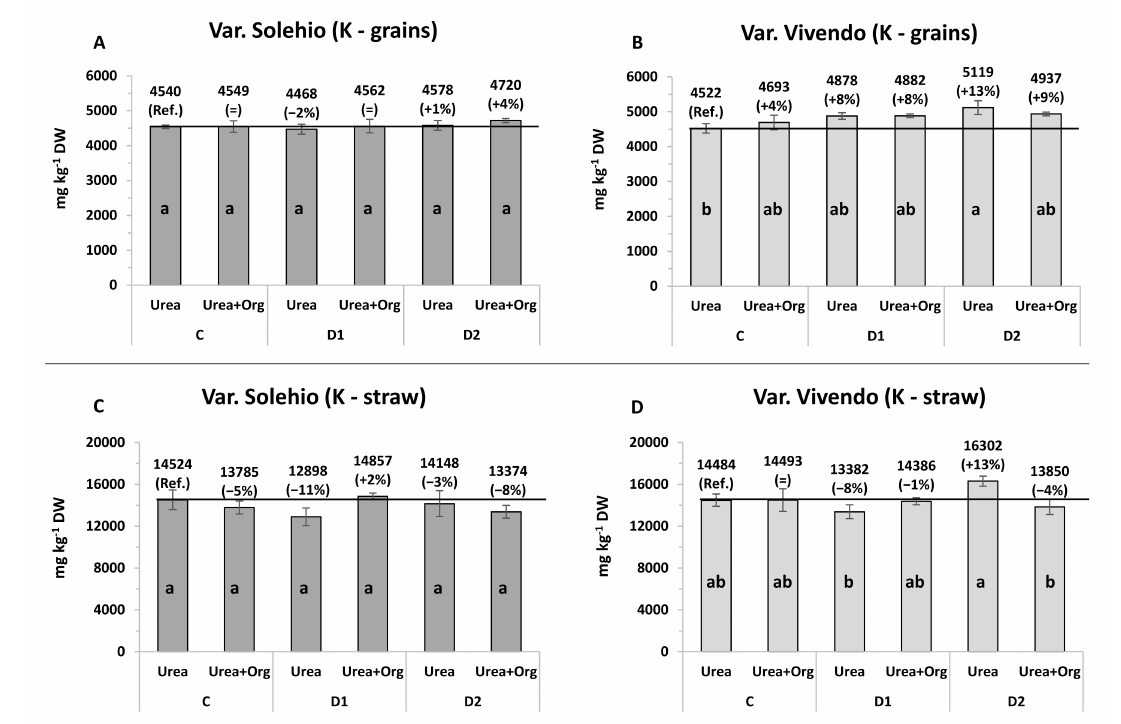
Figure 3. Potassium concentration (mean ± S.E.; n = 3) in grains and straw at harvest in the wheat varieties Solehio ( A , B ) and Vivendo ( C , D ) following the biofortification treatment with D1 and D2 doses of Ca + Mg + K, applied, together with urea (Urea) and urea + organic (Urea + Org) nitrogen fertiliser, and in the two controls C_Urea and C_Urea + Org without cations. Letters above histograms indicate significant differences between treatments (Student–Newman–Keuls test; p ≤ 0.05). In brackets: % variation of treatments vs. urea control